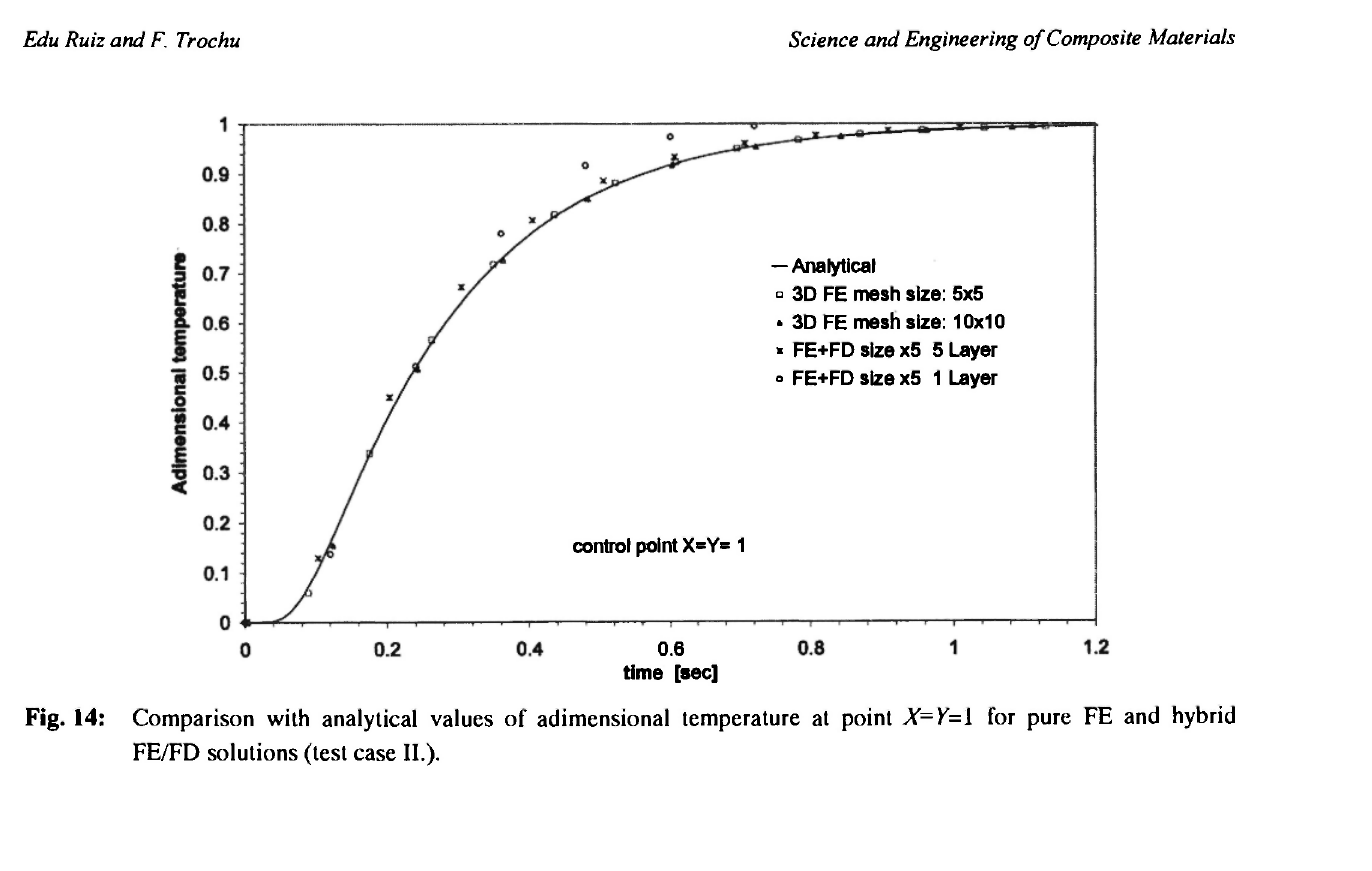
Comparison with analytical values of adimensional temperature at point X=Y= 1 for pure FE and hybrid FE/FD solutions (test case II.).